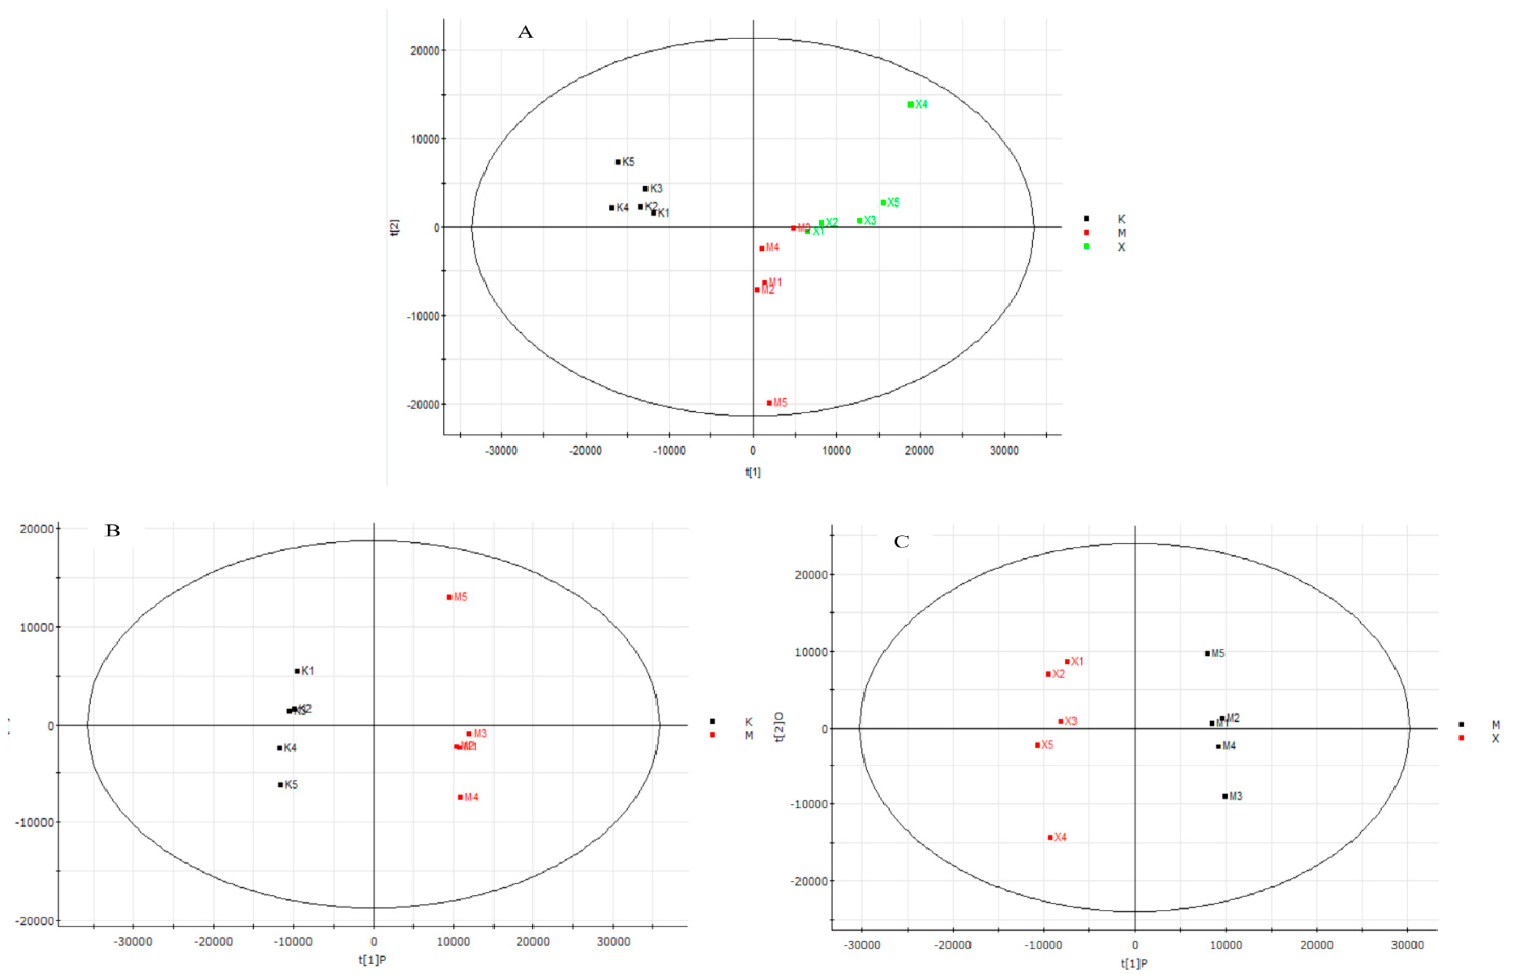
Figure 3. PCA and OPLS-DA score charts of control (K), model (M), administration (X) group. ( A ). PCA score chart of K, M and X group; ( B ): OPLS-DA score charts of K and M group; ( C ). OPLS-DA score charts of M and X